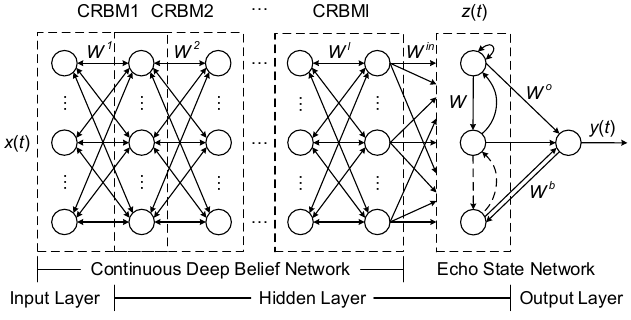
Figure 3. CDBESN model structure.